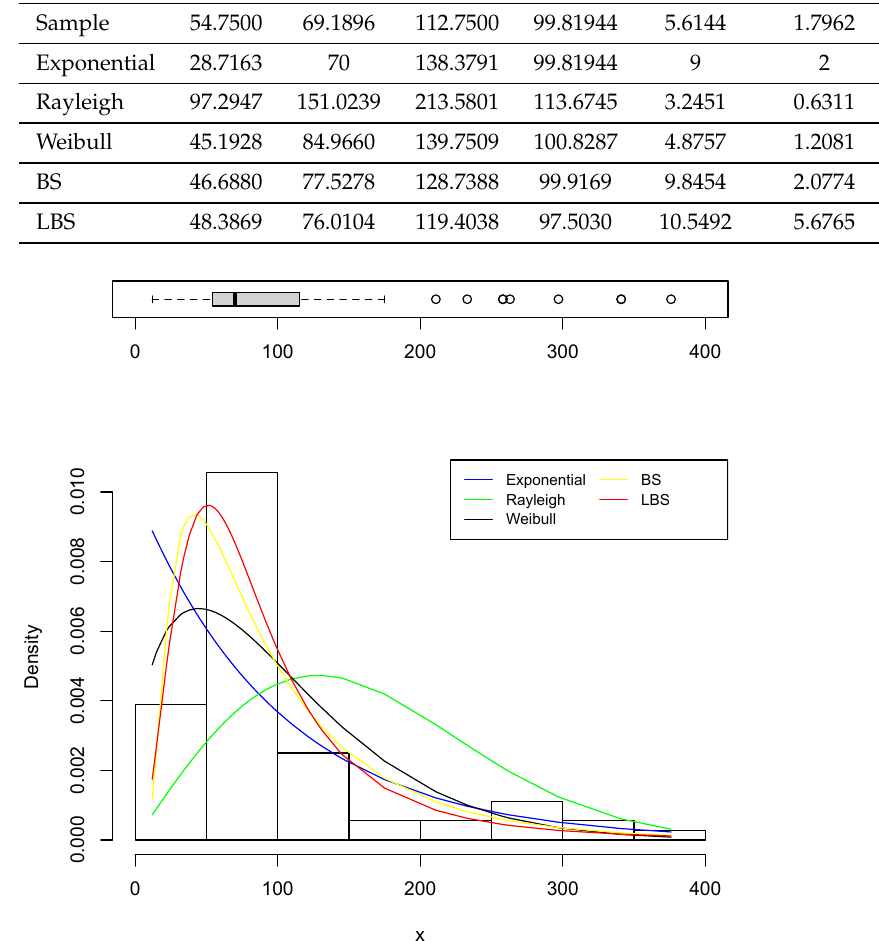
Figure 10. The fitted PDFs based on Cavia Porcellus